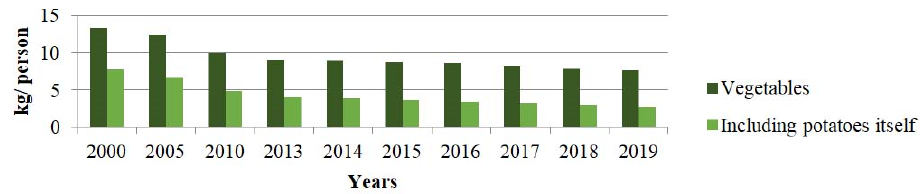
Figure 3. Average monthly consumption of vegetables in Poland (kilogram/person) in the years 2000–2019 [26] (pp. 183, 2000–2019 [26] (pp. 183, 336).